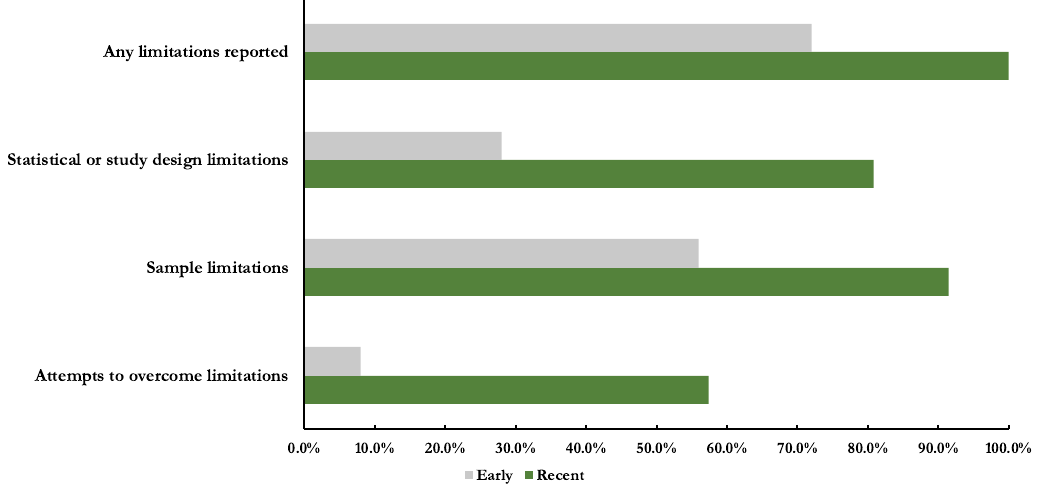
FIG. 4. Percentage of manuscripts that had reported on limitations, disaggregated by recent (2012 – 2017) and early (1992 – 2011).